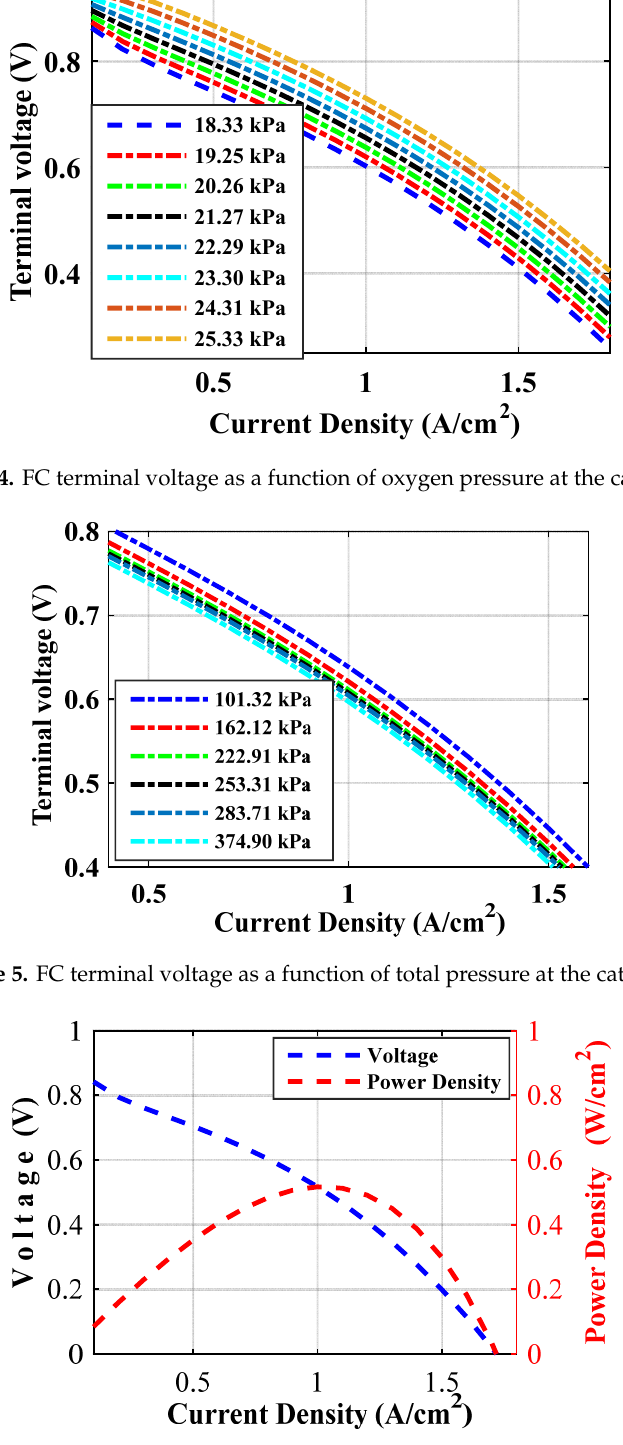
Figure 6. FC power density as a function of current density.